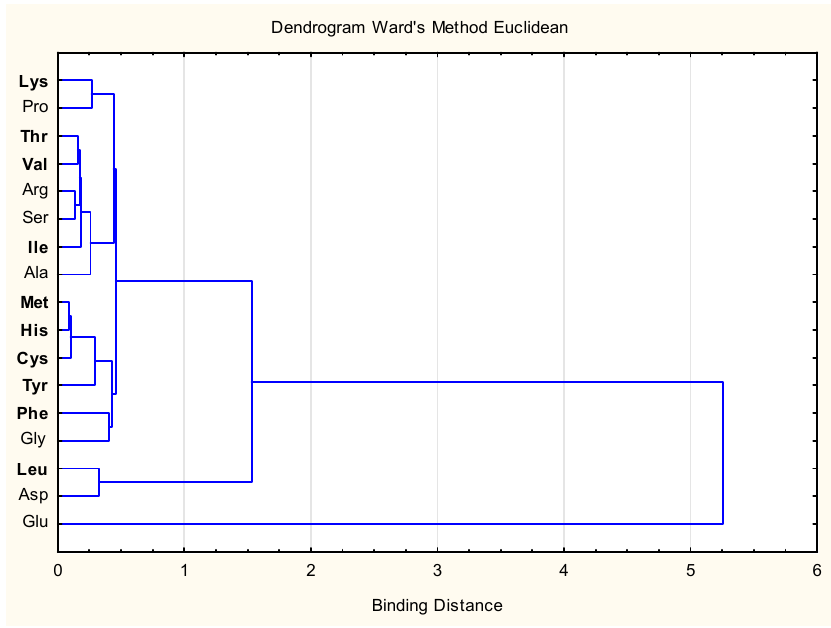
Figure 1. Dendrogram of system cluster analysis of amino acid composition results in analyzed organic protein bars (Ward’s method, Euclidean). Explanations: the highlighted designations of amino acids mean essential amino acids (EAA): Ala—Alanine; Arg—Arginine; Asp—Aspartic acid; Cys—Cysteine; Glu—Glutamic acid; Gly—Glycine; His—Histidine; Ile—Isoleucine; Leu—Leucine; Lys—Lysine; Met—Methionine; Phe—Phenylalanine; Pro—Proline; Ser—Serine; Thr—Threonine; Tyr—Tyrosine;